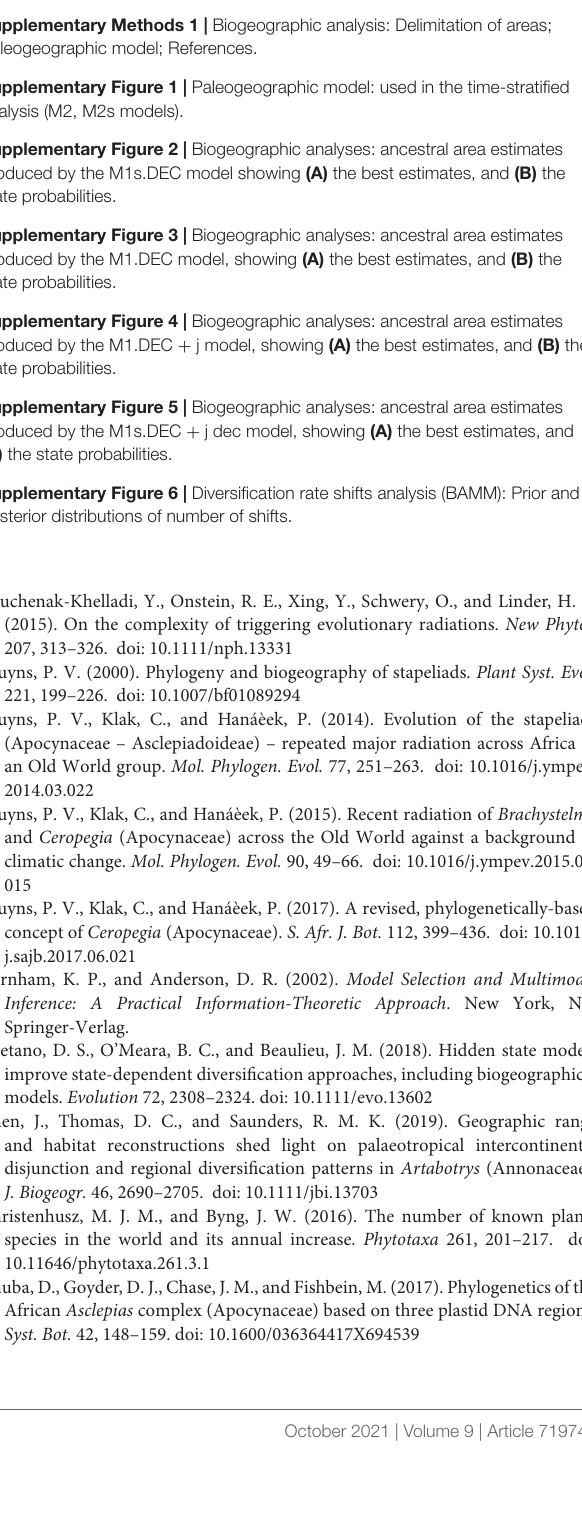
Supplementary Table 2 | Biogeographic analyses: model comparison results (a: considered; b: incl. + J). Supplementary Table 3 | Biogeographic test: model definition. Supplementary Table 4 | BSM: dispersals estimated under the M1s.DEC + J model. Supplementary Table 5 | Biogeographic tests: model comparison results (all test models). Supplementary Table 6 | Diversification rates analysis (MiSSE): model comparison results.